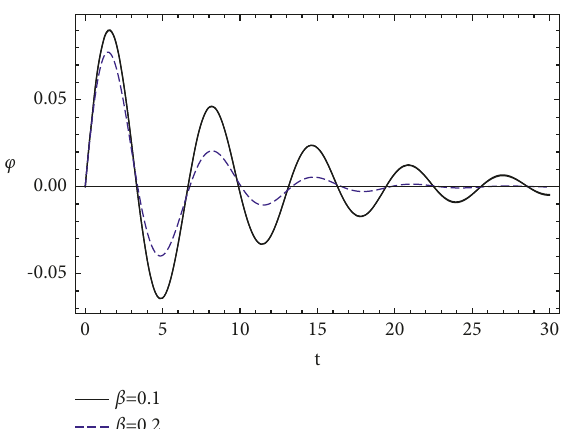
Figure 7: The analytical approximation (16) to i.v.p. (3) plotted in the β